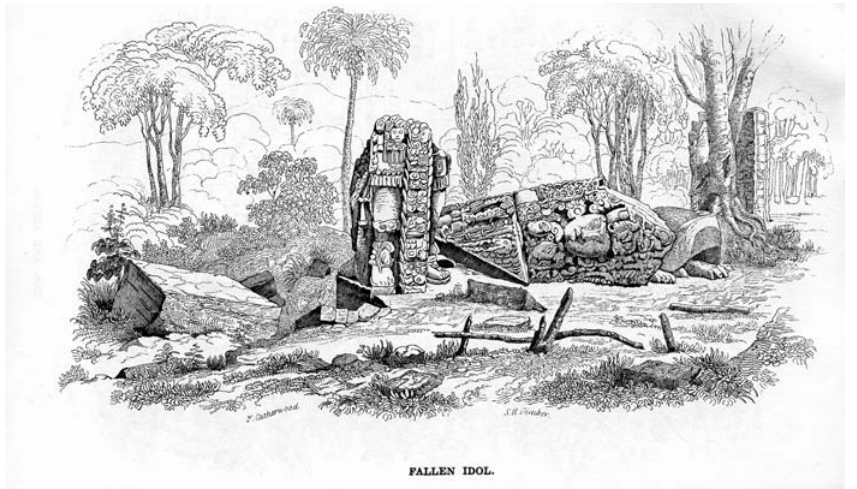
Figure 1 Frederick Catherwood’s atmospheric drawings of Copan helped create the idea of the total Maya collapse. From J. L. Stephens, Incidents of Travel in Central America, Chiapas, and Yucatan (New York: Harper and Brothers, 1841).